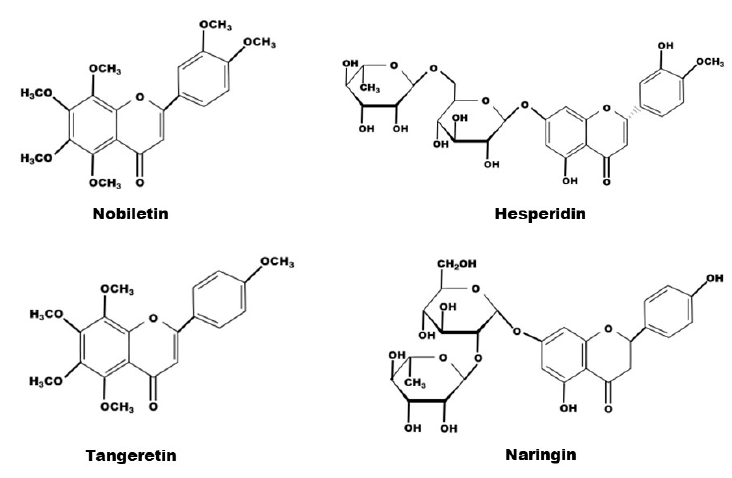
Figure 2. The chemical structure of nobiletin, hesperidin, tangeretin and naringin contained in CRP.